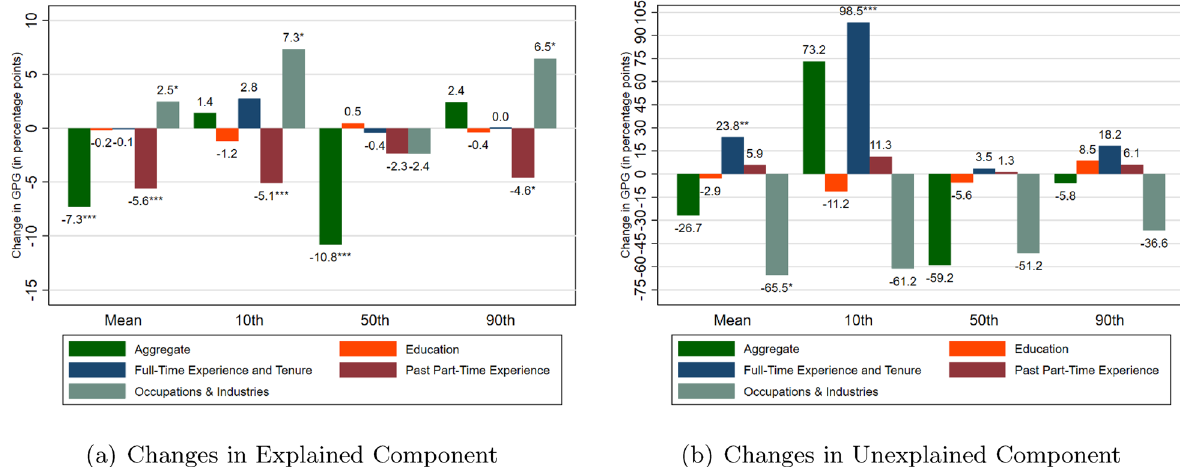
Fig. 1 Detailed double decomposition of changes in the gender pay gap 2020‑1984 at the mean and selected percentiles for selected sets of controls. Estimation based on approach outlined in Sects. 3 and 4. Men in 1984 are used as reference category. Aggregate refers to the change in the aggregate explained (panel ( a )) or unexplained (panel ( b )) component. Education, Full‑Time Experience and Tenure, Past Part‑Time Experience and Occupations and Industries are the changes in the corresponding parts (explained or unexplained) attributable to these sets of regressors. Education includes dummies for highest educational attainment. Occupations and Industries include occupation (ISCO 88, 1‑digit) and industry (NACE, level 1) dummies. Figure 2 shows the detailed double decomposition for the remaining sets of